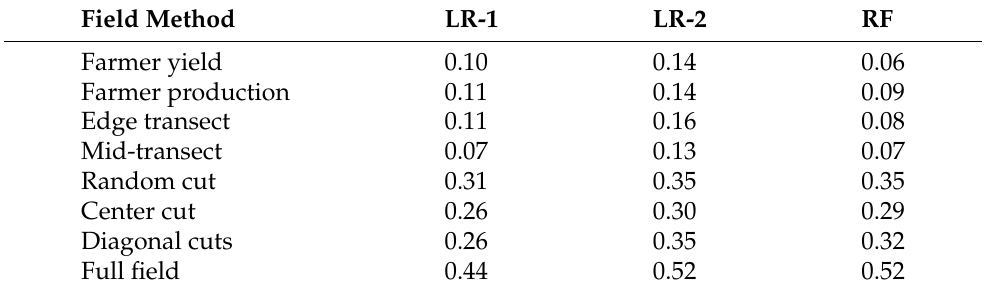
Table 3. Proportion of variation explained ( R 2 ) for yield prediction models. The highest score for any of the 45 single-variable linear regression models (LR-1) or for the 990 two-variable linear regression models (LR-2) and for Random Forest (RF)